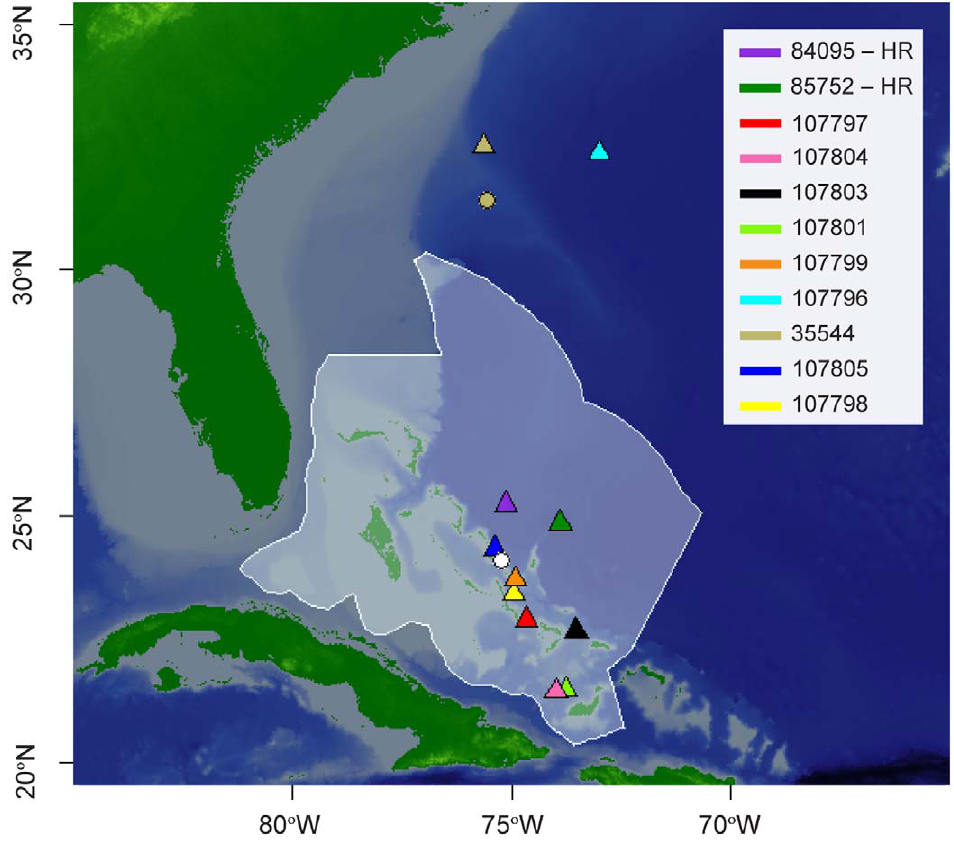
Figure 1. The white circle denotes the tagging location of tags deployed within the Bahamian EEZ and the beige circle denotes the tagging location of the single tag deployed outside the Bahamian EEZ. Color-coded triangles indicate pop-up location for individuals (listed by tag ID). The Bahamian EEZ is outlined in white, with white transparent fill.